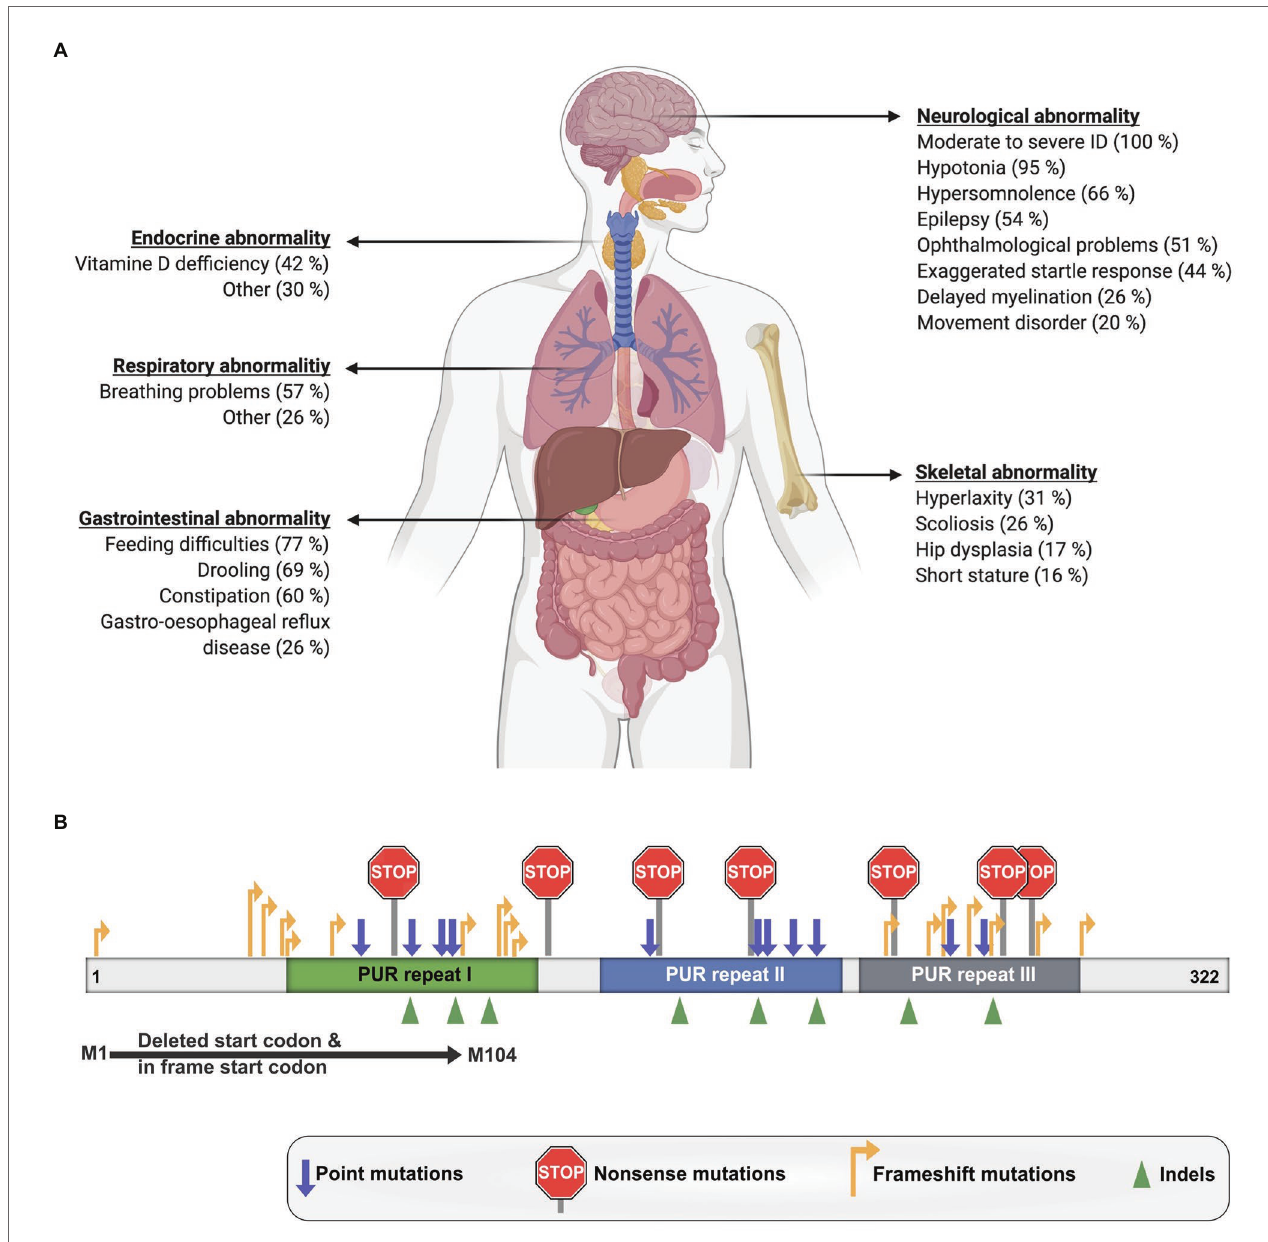
FIGURE 6 | Clinical manifestations of PURA syndrome and pathogenic mutations. (A) Clinical manifestations in PURA-syndrome patients and their relative frequencies. (B) Mutations causing PURA syndrome are scattered over most parts of the PURA open reading frame. Information presented in this figure is based on previously published data (Reijnders et al.,